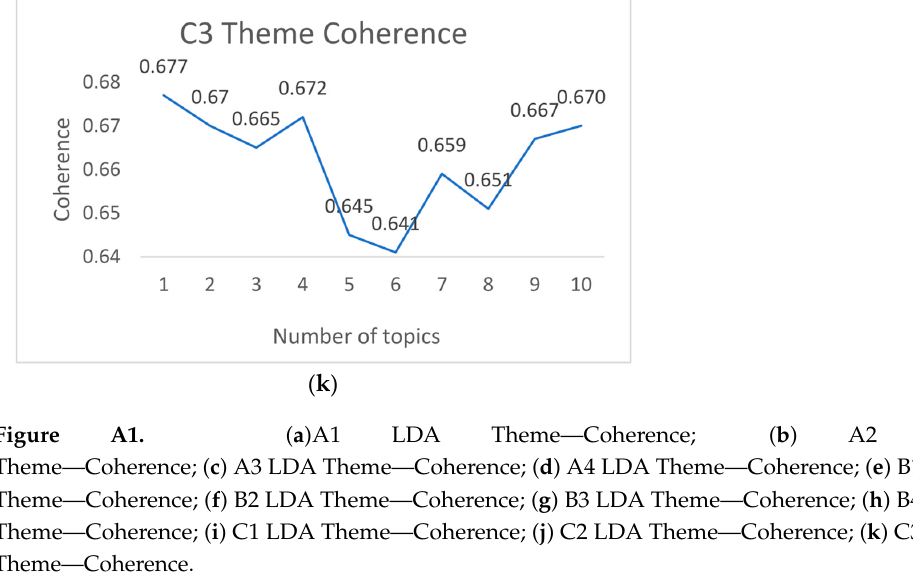
Figure A1. ( a )A1 LDA Theme—Coherence; ( b ) A2 LDA Theme—Coherence; ( c ) A3 LDA